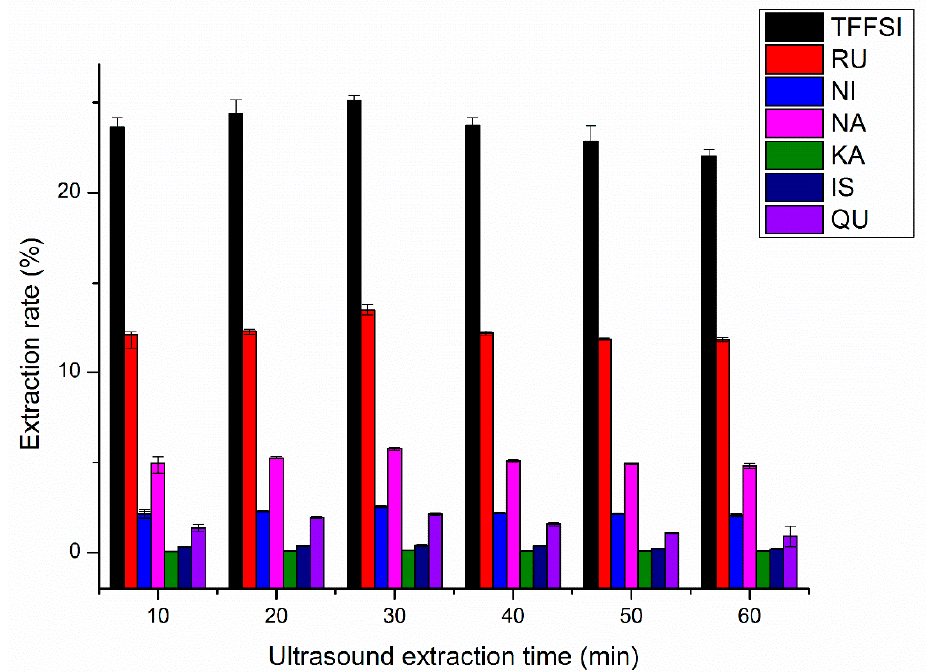
Figure 5. E ff ects of the ultrasound extraction time on the extraction rates of RU, NI, NA, KA, IS, QU, and the TFFSI.